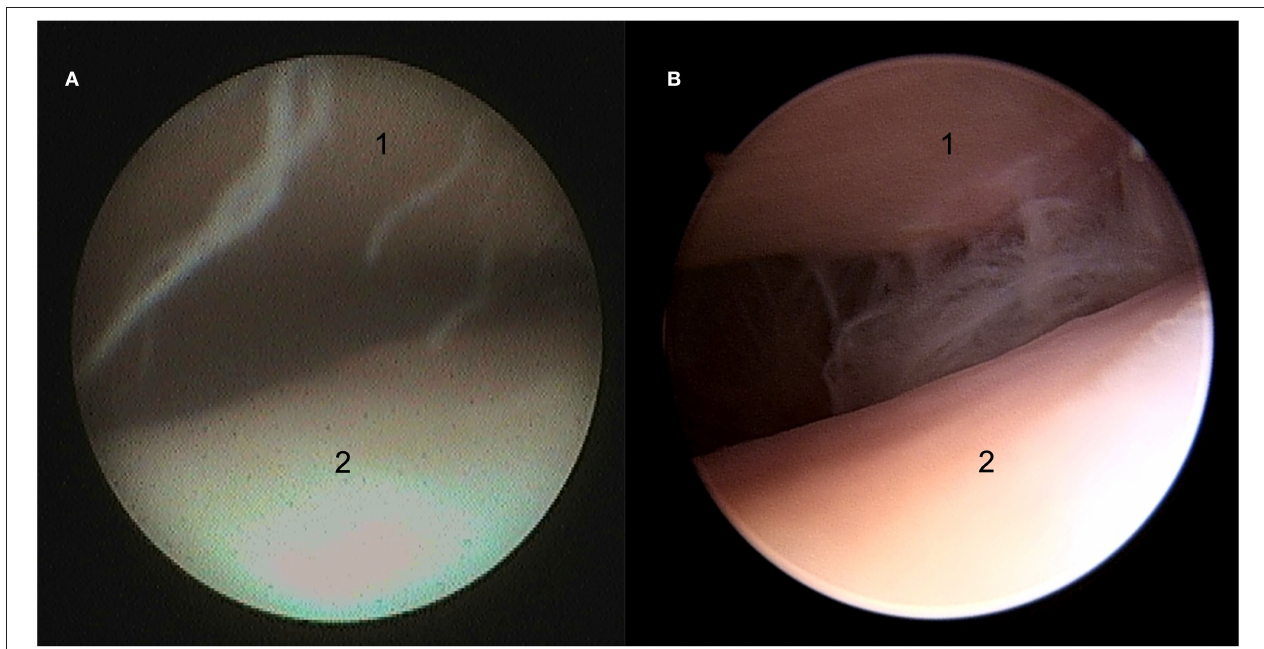
FIGURE 1 | Still arthroscopic image of the medial aspect of the discotemporal joint (DTJ) using the needle (NAS) (A) and standard (STAN) (B) arthroscopic systems. 1, the articular eminence of the temporal bone; 2, intra-articular disc.